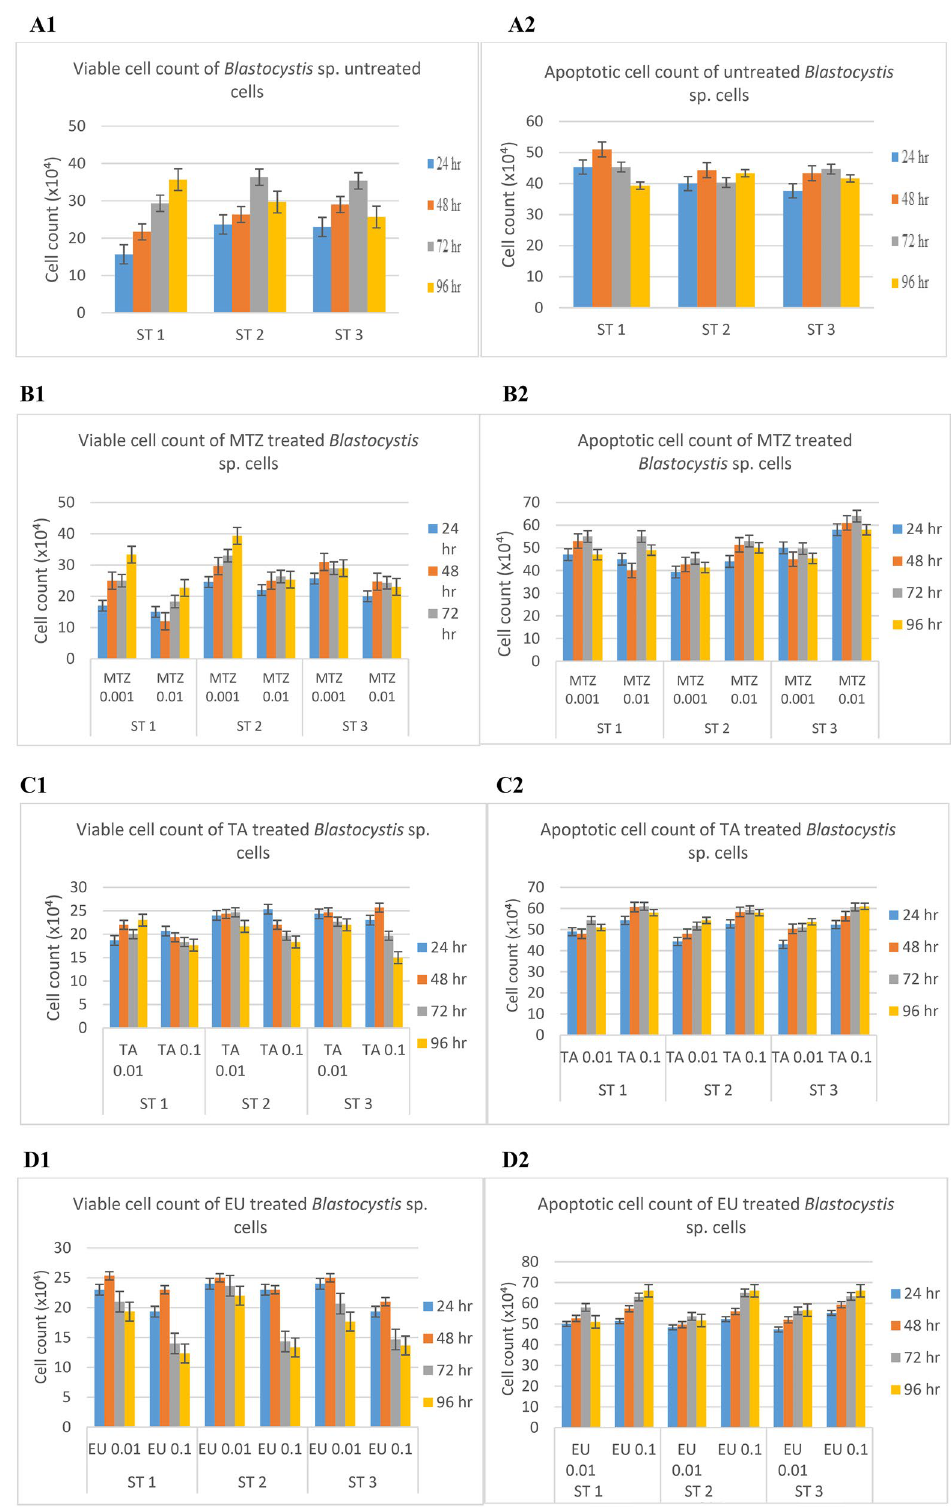
Figure 4. Number of viable cells and rate of apoptosis in Blastocystis sp.: ( A1 , A2 ) untreated cells; ( B1 , B2 ) cells treated with 0.01 mg/ml and 0.001 mg/ml MTZ; ( C1 , C2 ) cells treated with 0.1 mg/ml and 0.01 mg/ml TA; ( D1 , D2 ) cells treated with 0.1 mg/ml and 0.01 mg/ml